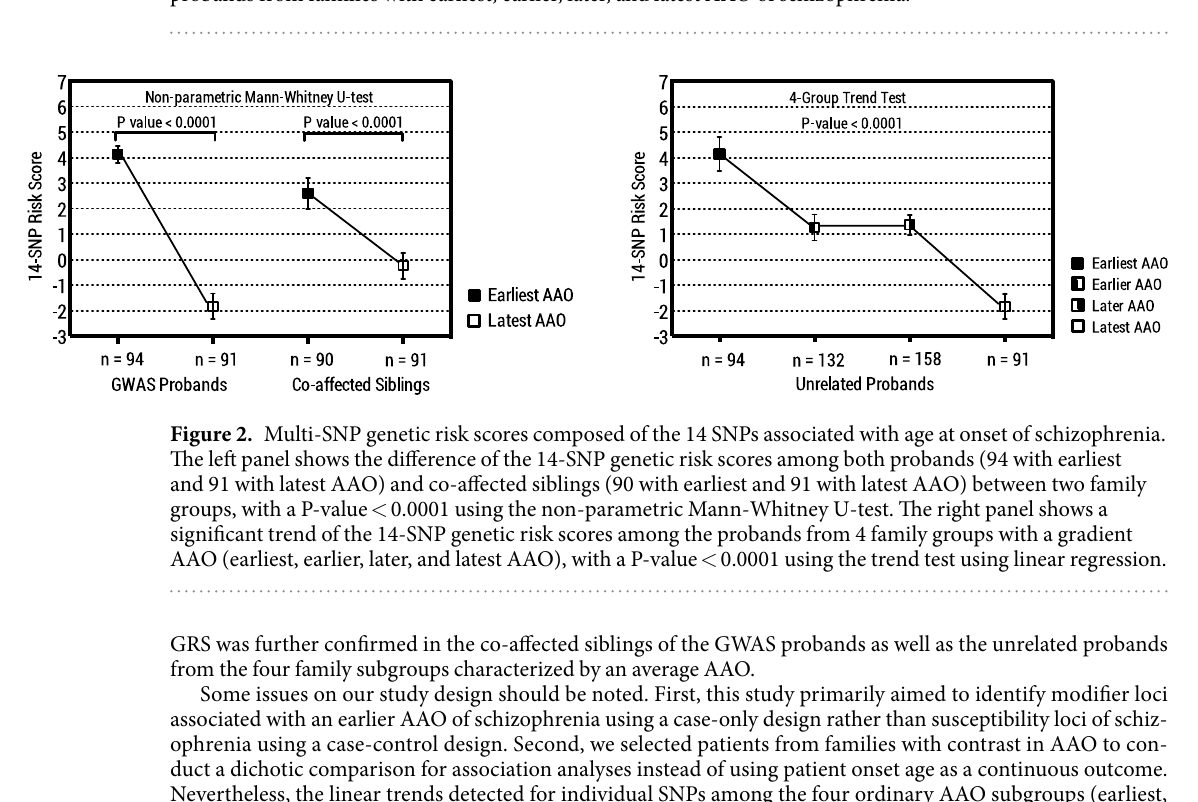
Table 2. The SNPs with suggestive signal associated with age at onset of schizophrenia between different comparisons Chr: chromosome; bold : SNP within the gene; italics : SNP near the gene; AL m : minor allele; AAO: age at onset; MAF E /MAF L : minor allele frequency in patients from families with earliest/latest AAO; OR a : odds ratio from association test using logistic regression; OR b : odds ratio from trend test using ordinal logistic regression. Empirical P presented the P-values obtained after up to 10 8 times of permutation of the multiple logistic model. § The trend effect of each SNP was tested using ordinal logistic regression among 4 groups of probands from families with earliest, earlier, later, and latest AAO of schizophrenia.